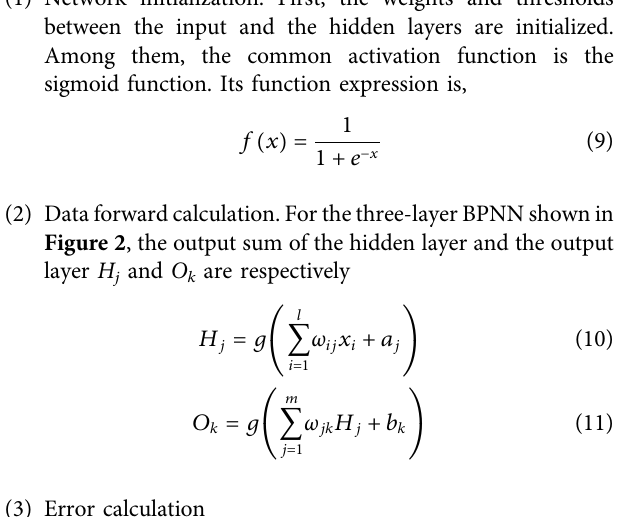
FIGURE 2 | Schematic diagram of the topology structure of